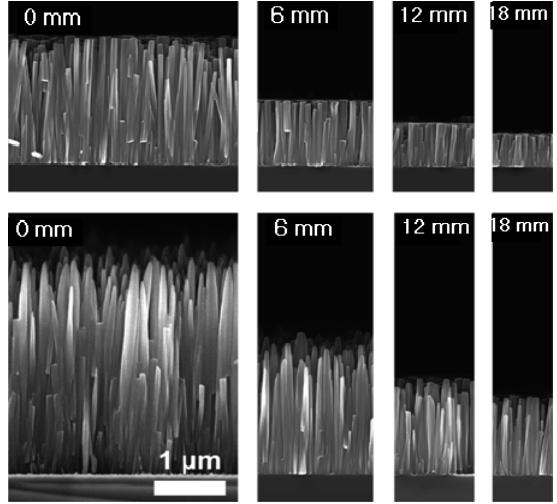
Figure 3. Cross-sectional SEM images of ZnO nanowires prepared at flow rates of 0.72 mL/h ( top row ); and 2.88 mL/h ( bottom row ) with an equimolar inlet concentration of zinc nitrate and Hexamethylenetetramine (HMT) Dimensions in each panel present the position where images were taken downstream from the inlet. The scale bar applies to all image. Reproduced from